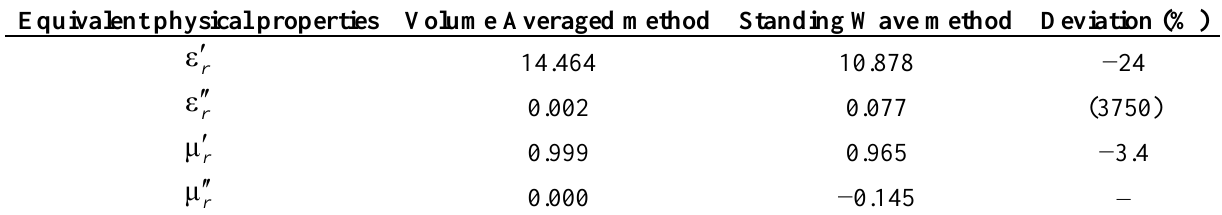
Table 7. Equivalent physical properties of particle-shaped aluminum (volume rate: 80%).